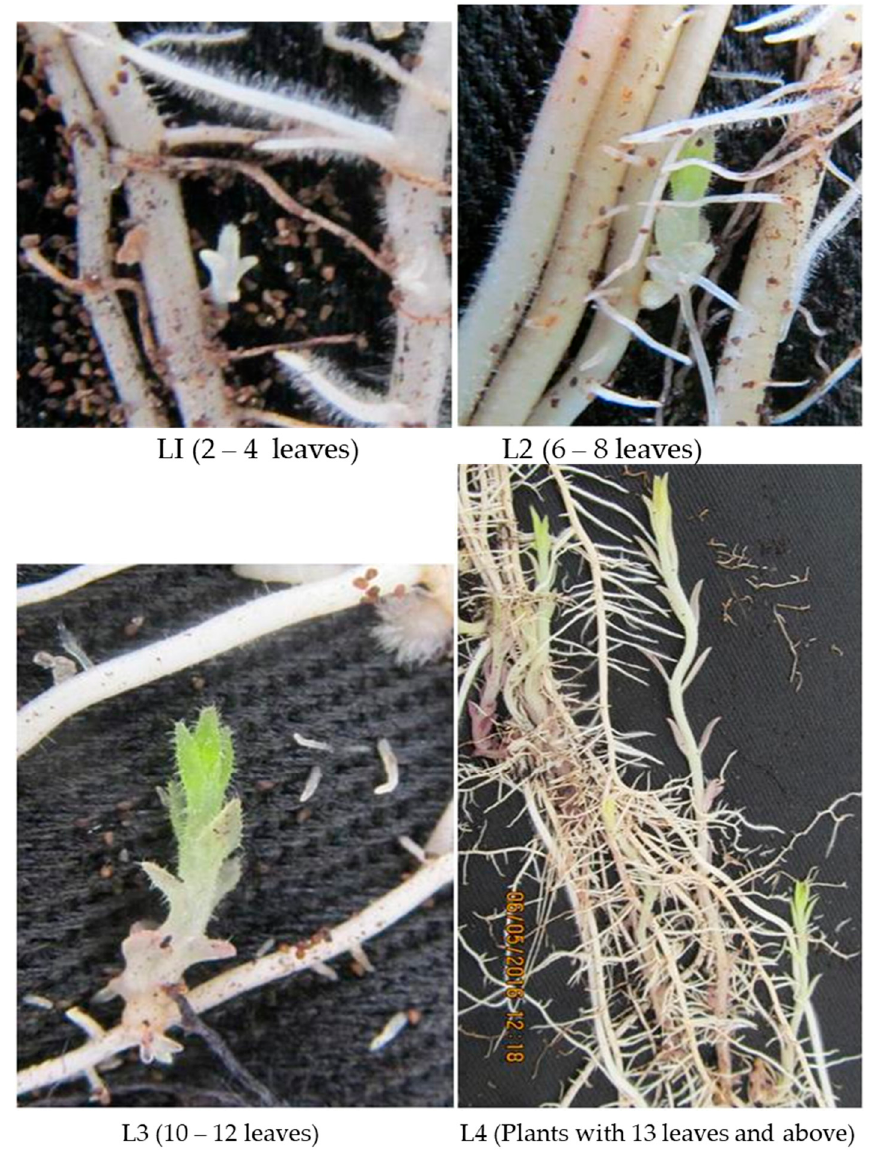
Figure 1. Growth stages of attached Striga plants.